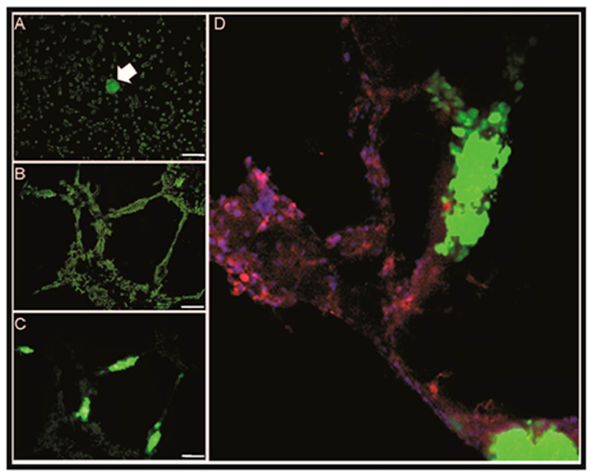
Figure 3. Vascular co-option in vitro model: ( A ) Merged brightfield-green fluorescent filter image of ECs (unlabeled) co-incubated on day 0 with a cancer sphere (marked with an arrow) composed of cells from the Ishikawa endometrial cancer cell line labeled with the green fluorescent protein ZsGreen; ( B ) merged image of cancer cells and EC tube formation at Day 5; ( C ) green filter image at Day 5 showing co-option (fluorescent cancer cells growing exclusively upon the tubular structures formed by the ECs in matrigel); and ( D ) zoom immunocytochemistry of EC (CD31+, stained red)-cancer cell (ZsGreen fluorescent) co-cultures. (Scale bars for A, B, C: 100 μ m.)